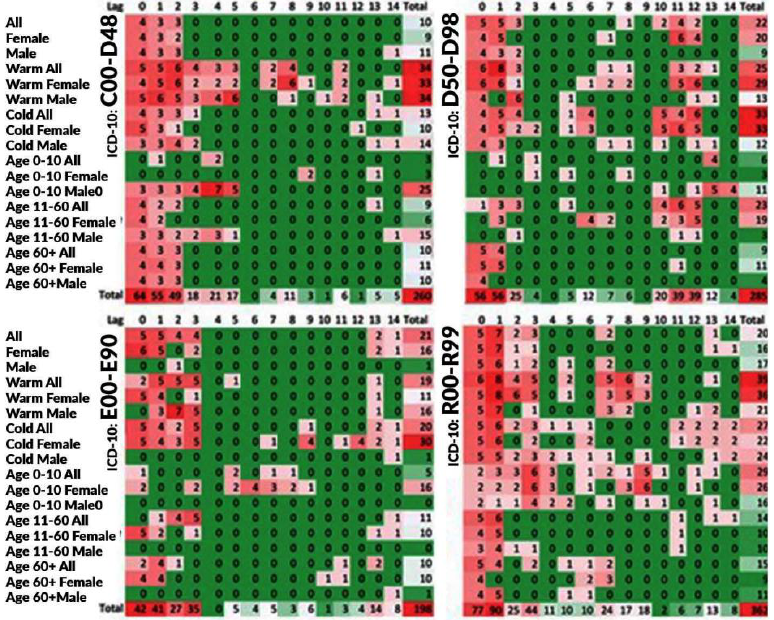
Figure 3. Frequencies of the numbers of positive statistically significant ( p -value < 0.05) associations